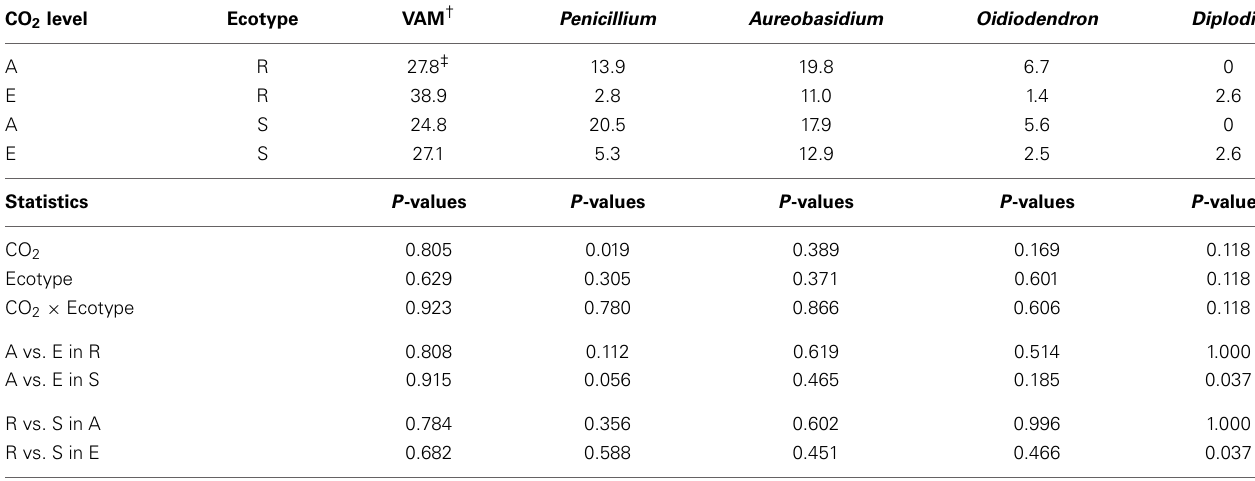
Table 4 | Effects of atmospheric CO 2 concentration (ambient, A = 375 µ mol mol − 1 ; elevated, E = ambient + 200 µ mol mol − 1 ) on frequency of fungi associated with two ecotypes (R = Resistant; S = Susceptible to Glyphosate) of common ragweed